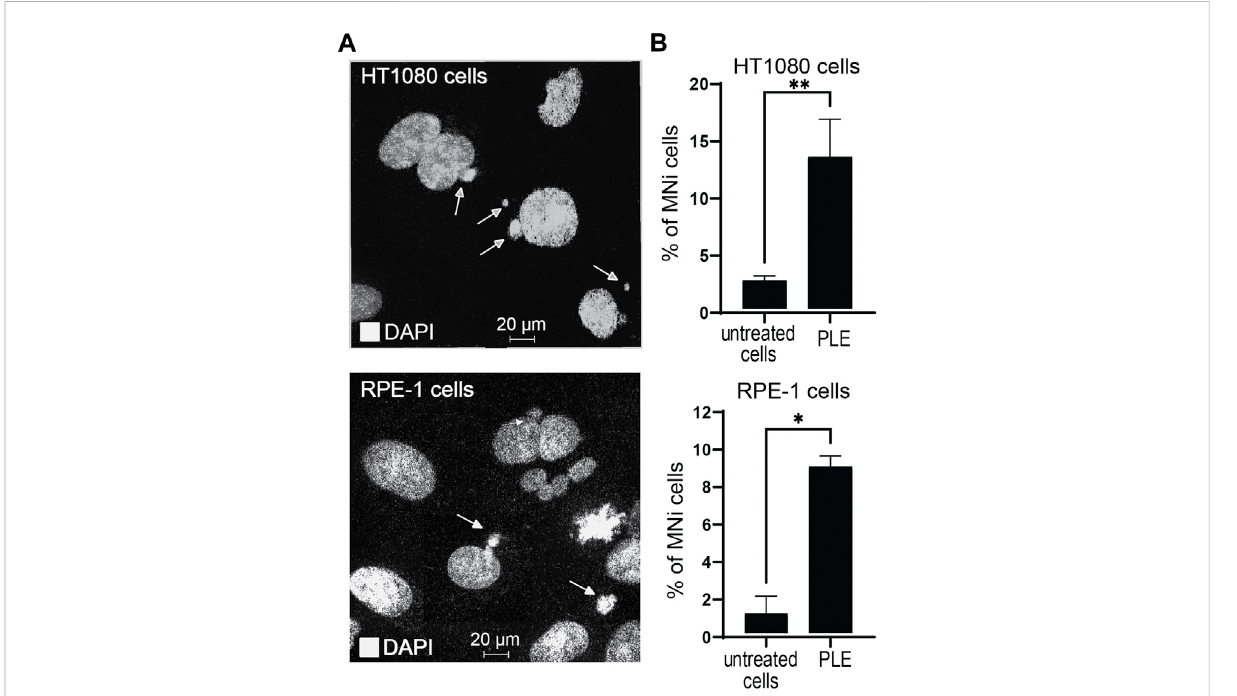
Micronuclei (MNi) formation 24 h after PLE treatment of HT1080 and RPE-1cells. (A) Examples of (MNi) formation in HT1080 and RPE-1 cells. White arrows point to the MNi. (B) The percentage of MNi after PLE treatment compared to untreated cells. Error bars correspond to a